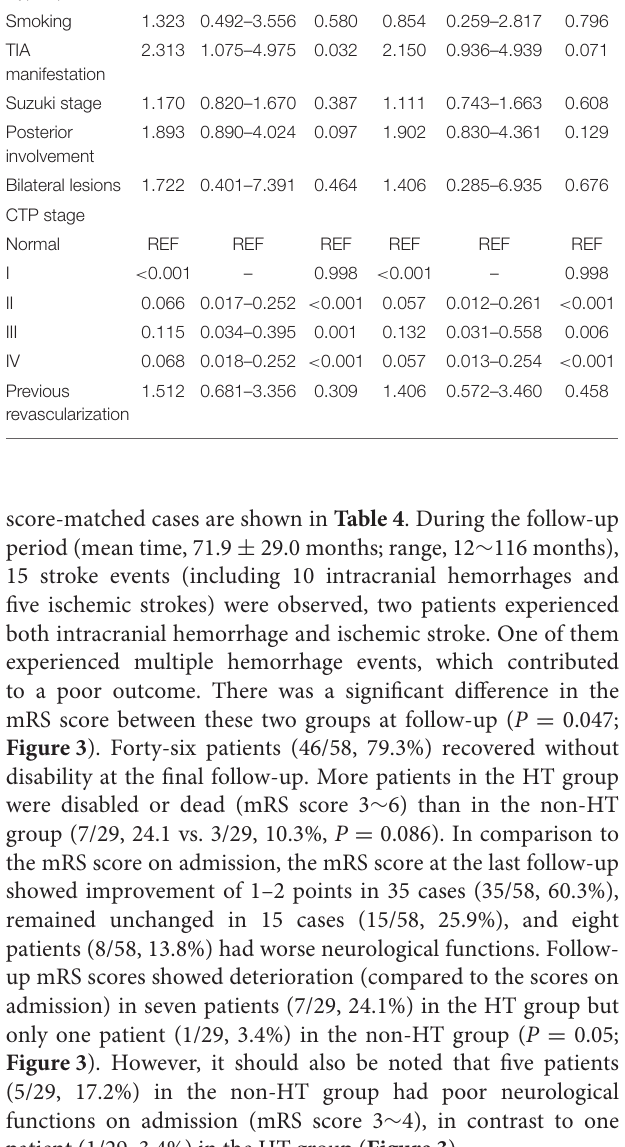
months; range, 3 ∼ 65 months). Intraventricular hemorrhage